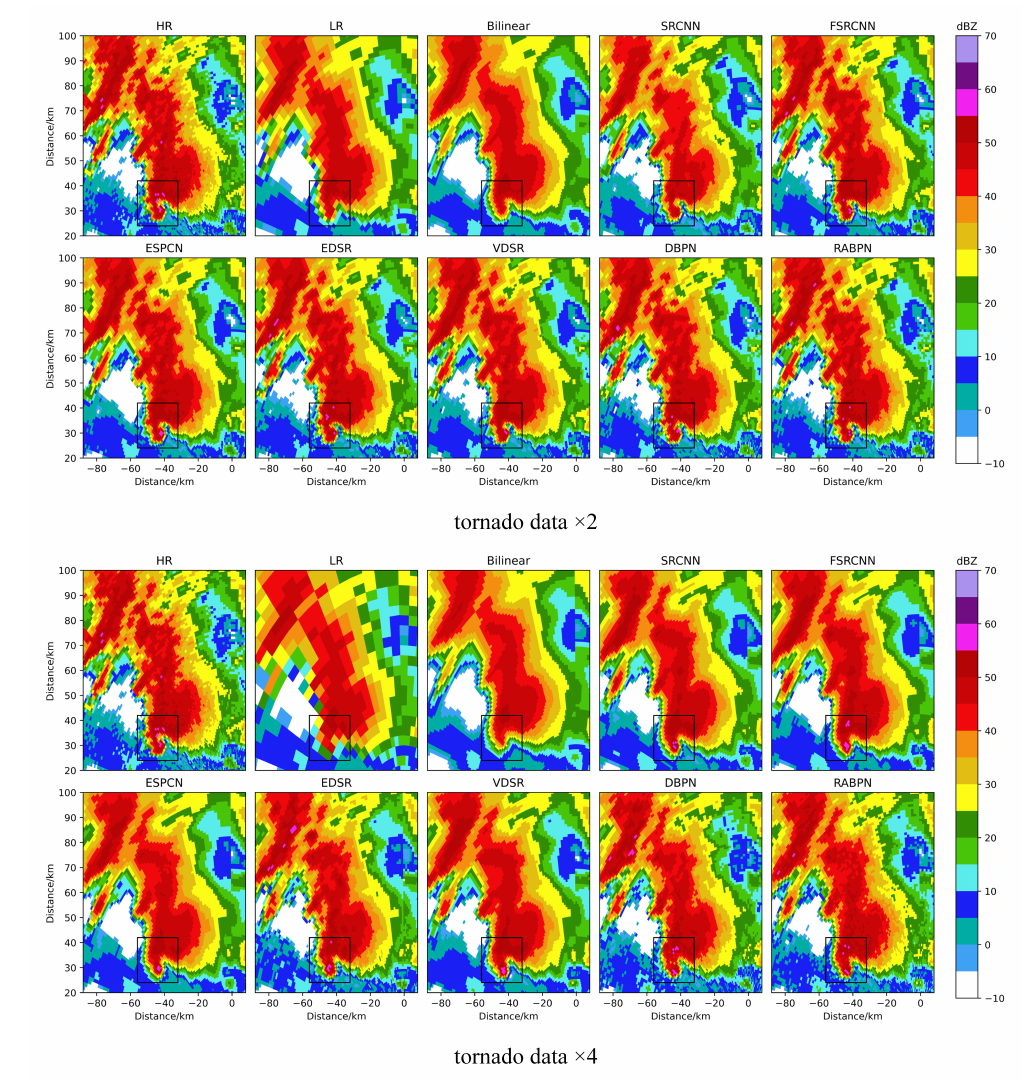
Figure 11. Comparison of super-resolution reconstruction results of heavy tornado